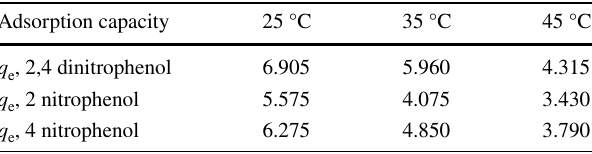
Fig. 13 Boyd plot for phenols adsorption onto char ash Table 6 Effect of temperature on the adsorption capacity of phenolic compounds Adsorption capacity